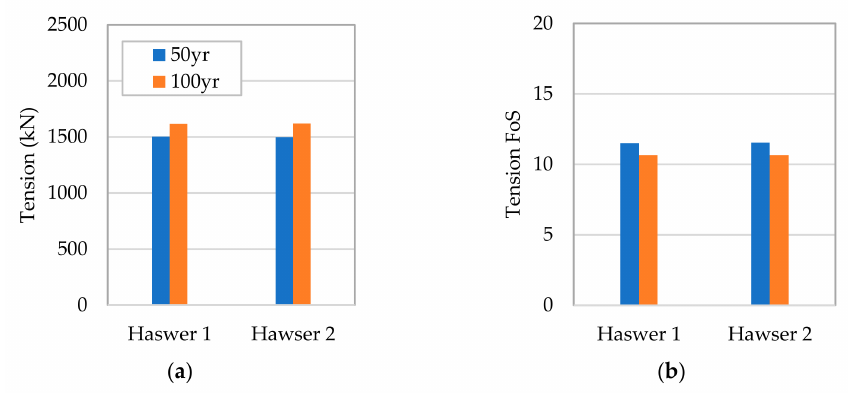
Figure 14. Platform hawser tensions for 50 and 100 y, heading 0 deg.: ( a ) tensions; ( b ) tension FoS. Mooring line tensions may vary due to the wave seeds used to generate the incident irregular waves. Six seeds are considered. Seed 1 is the default seed used for the analysis presented throughout this paper. For a comparison with the seeds, the tensions of each line are normalized by the respective tension by seed 1. The resulting values are compared from ML1 to ML6 for both 50 and 100 y in Figure 15. There are significant tension variations on the slack lines from ML1 to ML4, but small variations of − 6.4% to +7.3% for 50 y and − 7.2% to − 1.1% for 100 y are observed in the taut lines of ML5 and ML6. However, the mooring line strength designs are governed by the maximum tension of the taut lines rather than the slack lines, so it is confirmed that variation of the mooring FoSs due to the seeds is small. This indicates that the mooring line provides the strength to keep the buoy in place during the storm events.